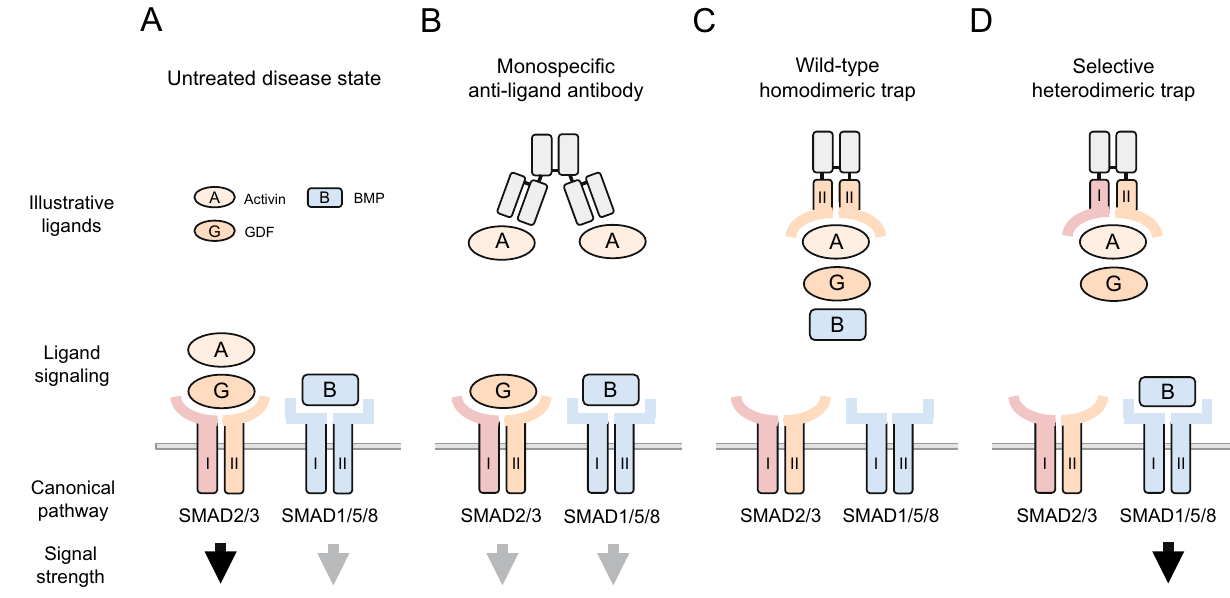
Figure 1. Hypothetical advantage of inhibiting functional subgroups of TGF-β superfamily ligands using selective heterodimeric traps. Human disease states are often characterized by imbalance between mutually antagonistic SMAD2/3 and SMAD1/5/8 signaling pathways. ( A ) In a hypothetical untreated disease state, excessive SMAD2/3 signaling (black arrow) occurs in combination with diminished SMAD1/5/8 signaling (grey arrow). A successful therapeutic intervention would restore normal balance between these two branches, and in some cases boost SMAD1/5/8 signaling, through selective inhibition of multiple SMAD2/3-activating ligands. ( B ) A monospecific anti-ligand antibody sequesters one SMAD2/3 ligand, but this partial inhibition might be inadequate to fully restore normal SMAD pathway balance. ( C ) A homodimeric ligand trap based on receptor ECD-Fc fusion might bind multiple ligands of both SMAD signaling branches, causing deleterious loss of SMAD1/5/8 signal. ( D ) A selective heterodimeric trap, engineered to target multiple ligands of the SMAD2/3 pathway but not of the SMAD1/5/8 pathway, could normalize SMAD pathway balance through robust inhibition of SMAD2/3 signaling while preserving SMAD1/5/8 signaling and potentially promoting it indirectly through disinhibition (black arrow). I, type I receptor or its ECD; II, type II receptor or its ECD. Ligands and endogenous receptors are depicted as monomeric for